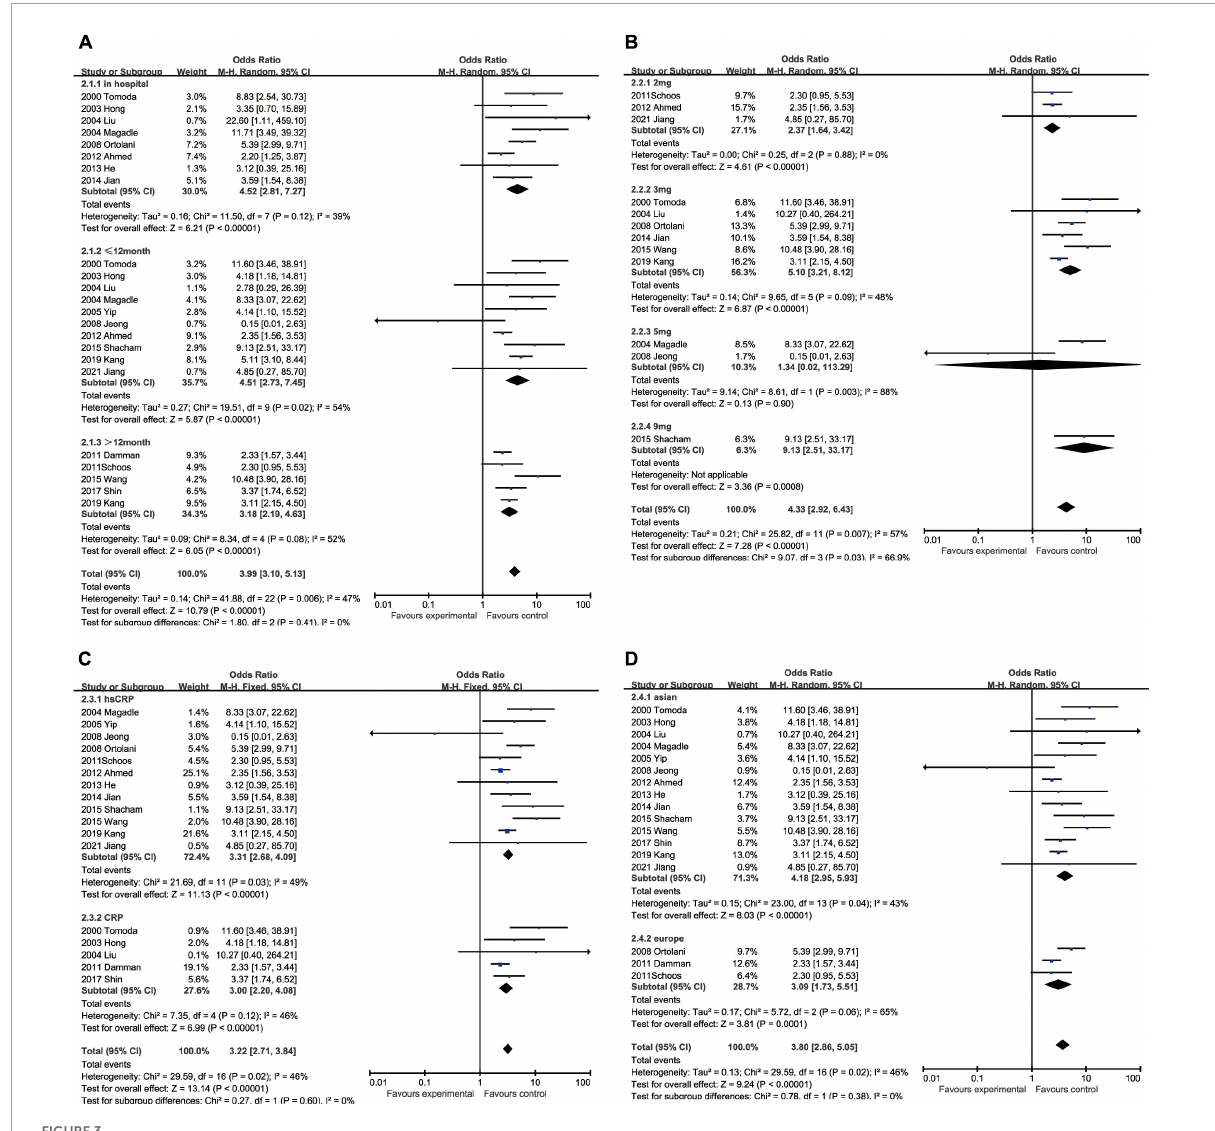
FIGURE3 Forrest plots of subgroup analysis assessing all-cause mortality associated with increased CRP: (A) subgroups based on follow-up; (B) subgroups based on cut-off value of hsCRP; (C) subgroups based on CRP and hsCRP; and (D) subgroups based on